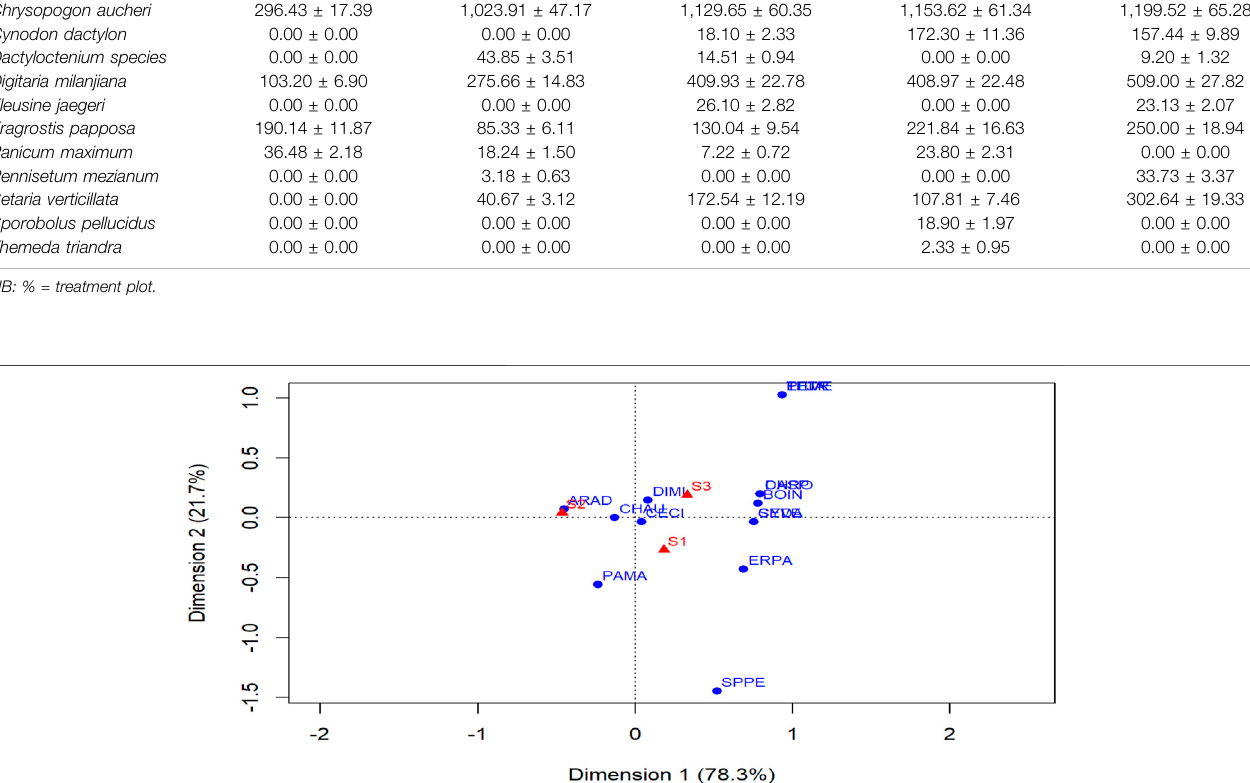
Frontiers in Environmental Science |